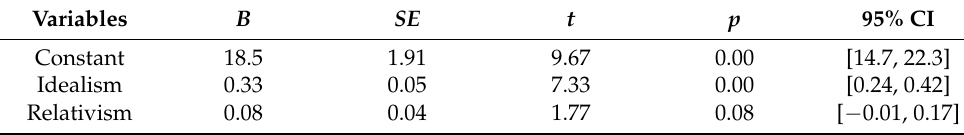
Table 8. Regression coefficient of idealism and relativism on attitude toward animals (N = 450).